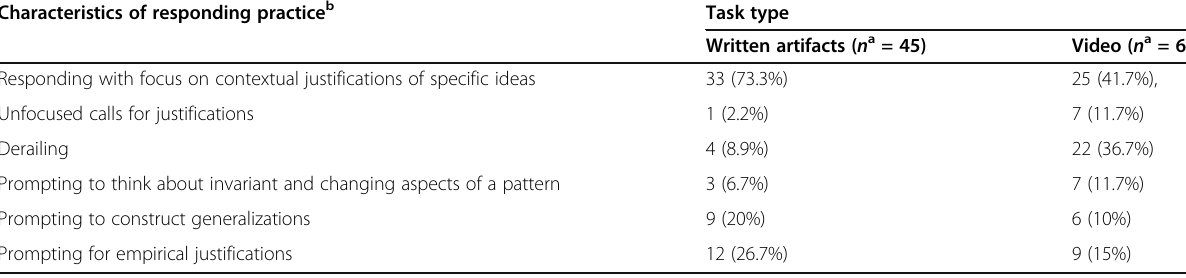
Table 3 Features of the responding practice Characteristics of responding practice